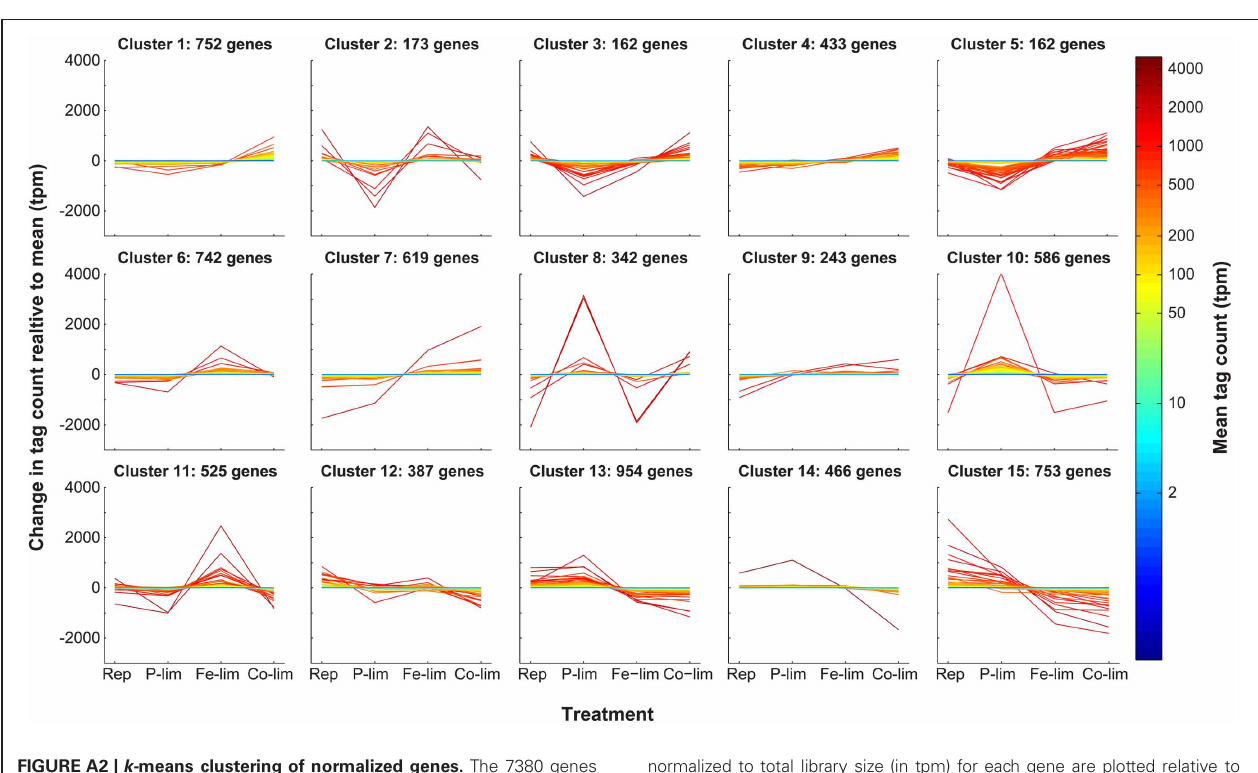
FIGURE A2 | k- means clustering of normalized genes. The 7380 genes that passed the 2.5tpm cutoff were clustered into 15 clusters using the k -means algorithm under the Pearson correlation coefficient. Tag counts